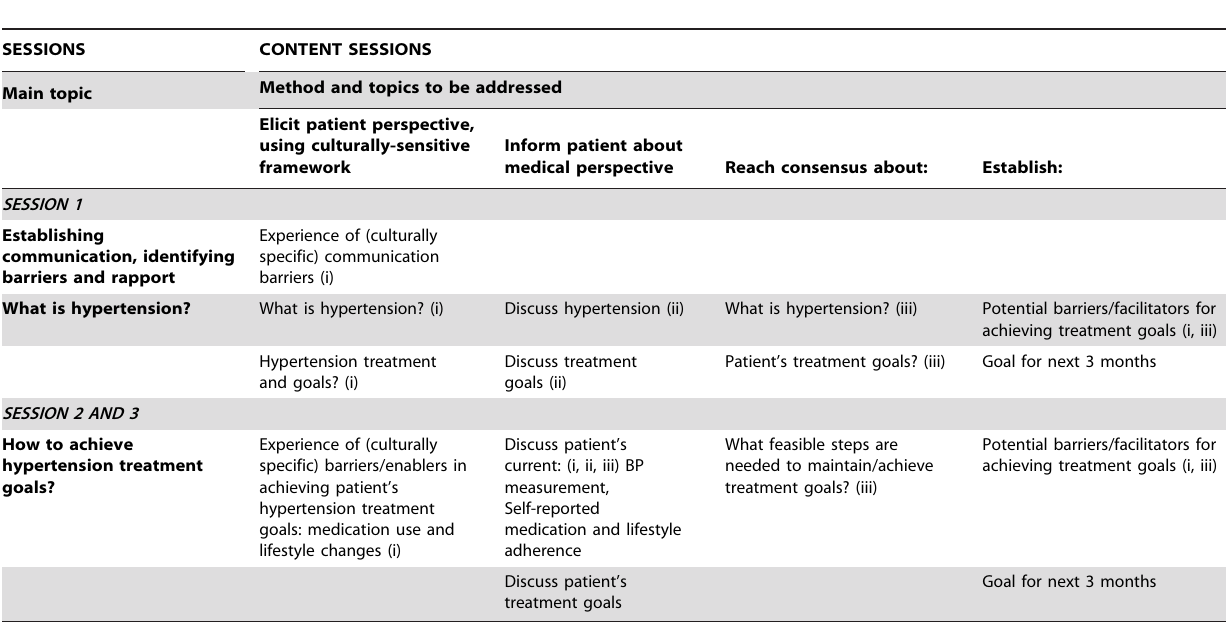
Table 1. Summary of three culturally adapted hypertension education